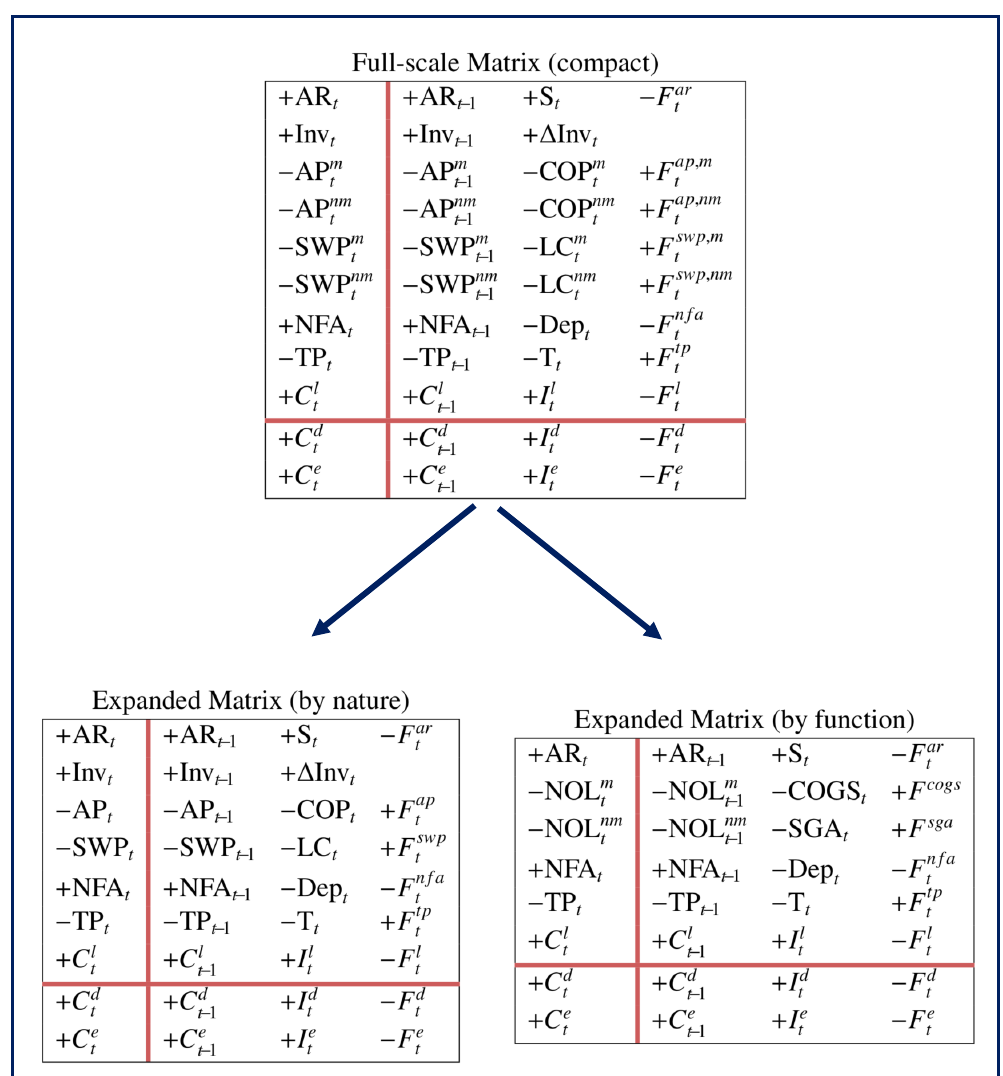
Figure 4. Expanded Matrices generated by Full-scale Matrix. Expanded Matrix (by nature) is obtained by consolidating the items referring to purchases on one hand and the items referring to labor costs (salaries and wages) on the other hand; Expanded Matrix (by function) is obtained by consolidating the items related to manufacturing activities on one hand and nonmanufacturing activities on the other